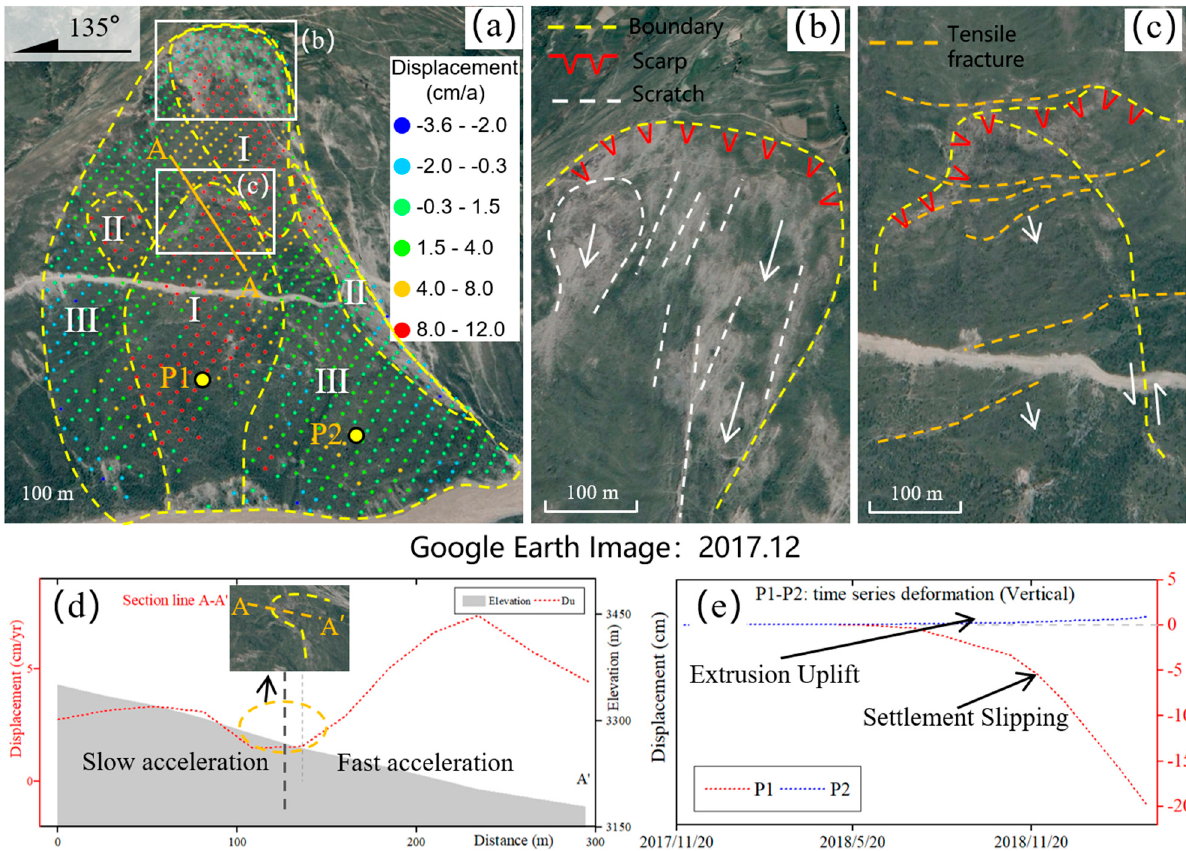
Figure 12. Local deformation and failure characteristics of the Xiaomojiu landslide. ( a ) SBAS-InSAR results obtained from PALSAR-2 SAR data; ( b , c ) images of local failure; ( d ) A-A’ deformation profile; ( e ) time-series deformation at P1 and P2 (background: modified from © Google Earth 2021).